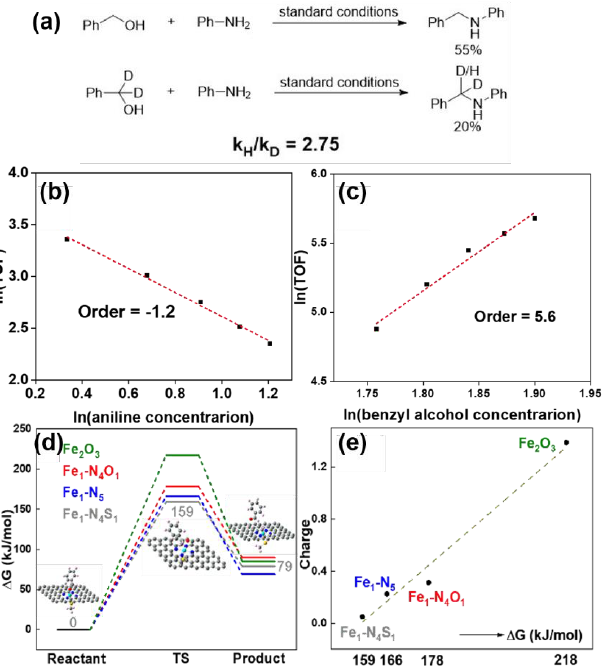
Figure 6. ( a ) The H/D kinetic isotope effect (KIE) experiment results. Plots of reaction orders of ( b ) aniline and ( c ) benzyl alcohol. ( d ) The energy barriers for Fe 2 O 3 , Fe 1 -N 4 O 1 , Fe 1 -N 5 and Fe 1 -N 4 S 1 sites. ( e ) The relationship between positive charge density of Fe sites and energy barriers. Reprinted with permission from Ref. [66]. Copyright 2021, Royal Society of Chemistry.